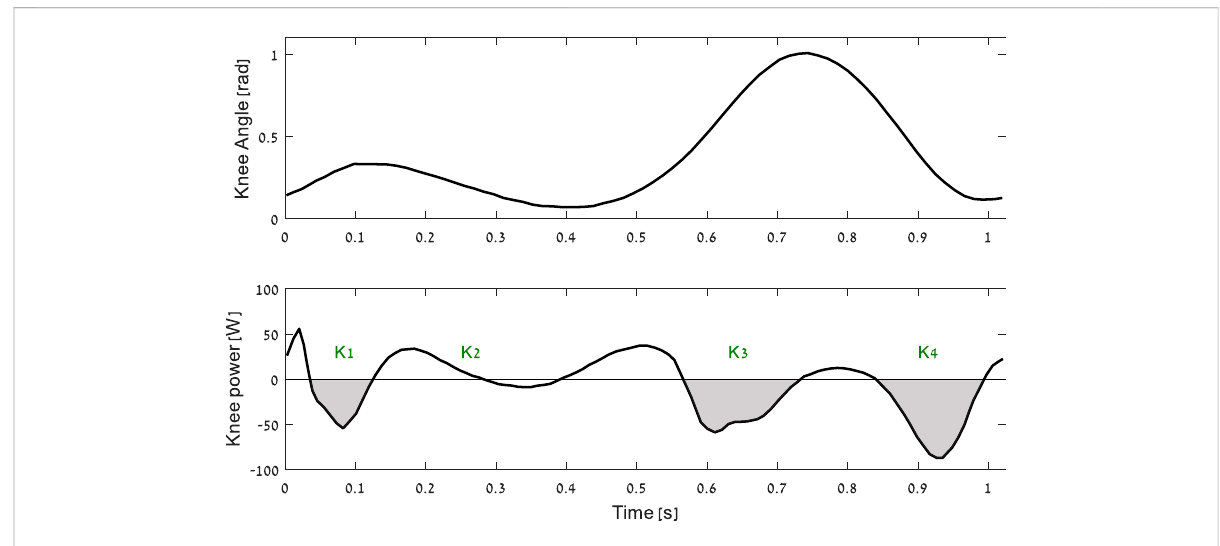
FIGURE 2 Themechanicsofthekneejointduringawalkinggaitcyclefromheelstriketoheelstrike.Theshadedareas(i.e.,K1,K3,andK4)arethephasesof negative net muscle work at joint level [based on (Winter,